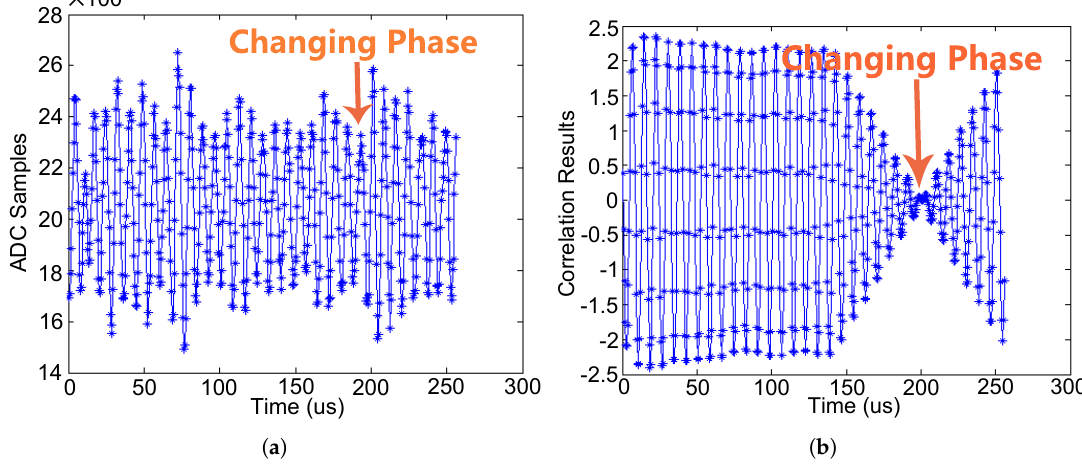
Figure 15. ( a ) ADC samples of the uplink receiving filter output; and ( b ) the correlation results of the matched filter in the uplink